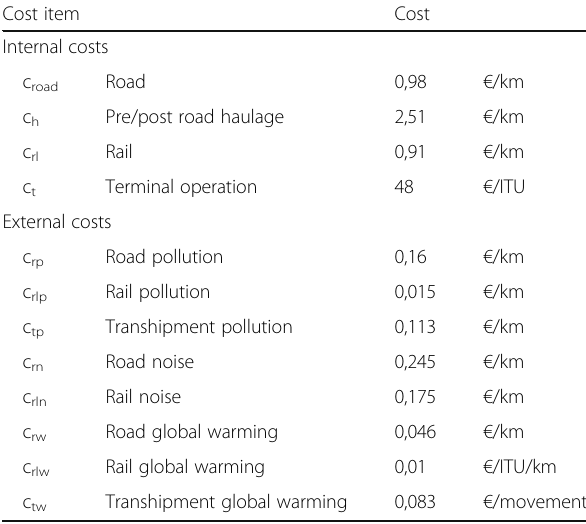
Table 1 Typical internal and external costs for freight transport (ITU 40 ′ ) (adapted from